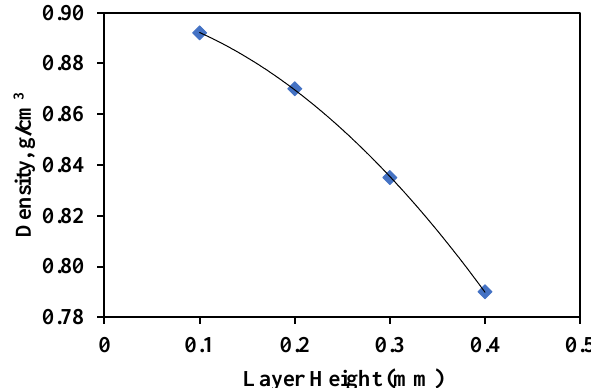
Figure 11. Density as a function of layer height for ABS w/5%CF.